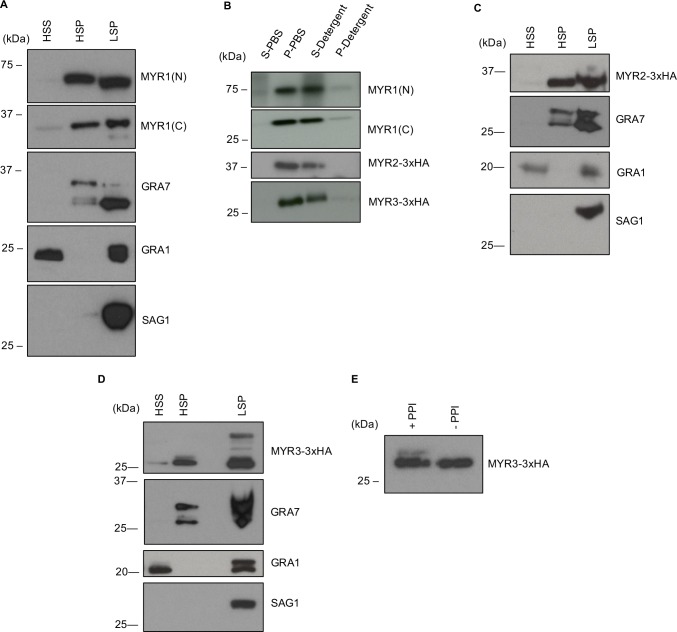
MYR1, MYR2, and MYR3 associate with membranes outside of the parasite.(A) Fractionation of MYR1 protein. HFFs were infected with RH Toxoplasma tachyzoites for 20–24 hours and then mechanically lysed in PBS with protease and phosphatase inhibitors. Parasites and host cell debris were pelleted at 2500 x g and this resulting low-speed pellet (LSP) was resuspended in lysis buffer, while the supernatant was further fractionated at 100,000 x g. Resulting high-speed supernatant (HSS) and pellet (HSP) as well as the LSP were resolved by SDS-PAGE and blotted with antibodies against MYR1(N) and (C) fragments, GRA7, GRA1 and SAG1. (B) The HSP fractions from (A), (D), and (C) were treated with PBS or detergents, fractionated at 100,000 x g, and the resulting supernatant (S-PBS or S-detergent) and pellet (P-PBS or P-detergent) fractions resolved by SDS-PAGE, blotted and probed as in (A). (C) As for (A), except using endogenously tagged RH:MYR2-3xHA62 tachyzoites and anti-HA antibody. (D) As for (A), except using endogenously tagged RH:MYR3-3xHA tachyzoites and anti-HA antibody. (E) HFFs were infected with RH:MYR3-3xHA tachyzoites and fractionated in PBS supplemented with protease inhibitors plus or minus phosphatase inhibitors (+PPI and -PPI, respectively) according to the protocol described in (A). The resulting HSP fractions were then resolved by SDS-PAGE, blotted and probed with anti-HA antibody.